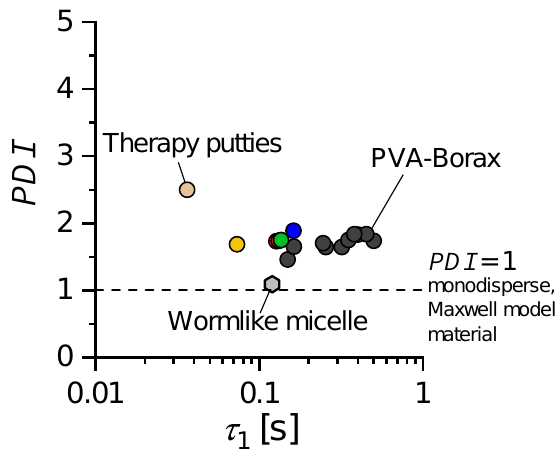
Figure 12: The polydispersity index PDI for all samples is small, but noticeably larger than 1. Therapy putties shown as colored circles, PVA-Borax as dark gray circles, and a wormlike micelle solution [107] as hexagon